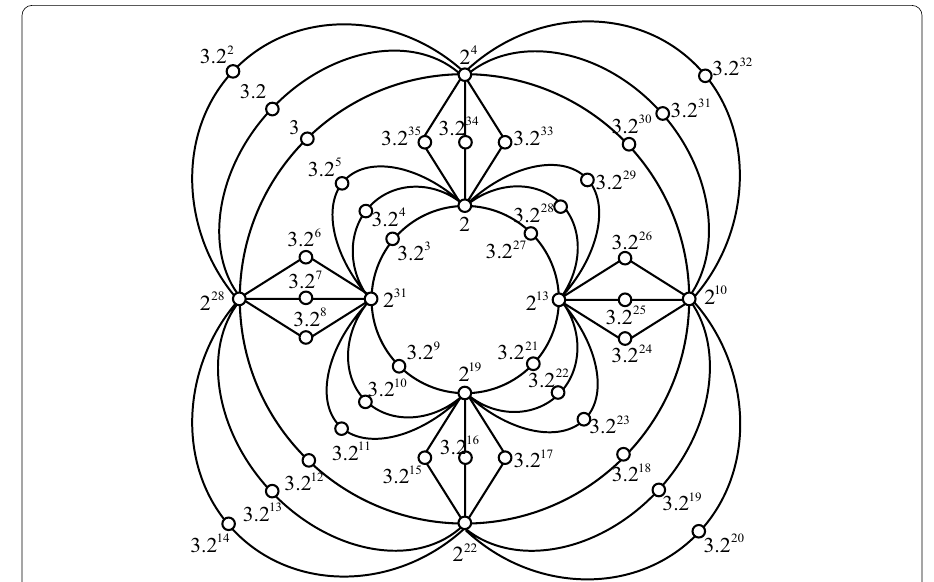
Fig. 9 21-Zumkeller labeling of SSD ( C 3 × P 4